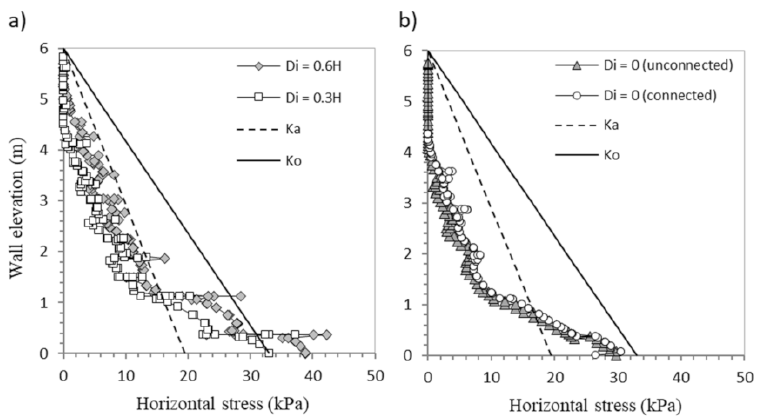
Figure 14. Lateral earth pressure behind the reinforcements (i.e., at L -distance from facing) at the end of construction (EoC) for different interaction distances ( D i ) between back-to-back reinforced soil walls: ( a ) D i > 0 and ( b ) D i = 0.